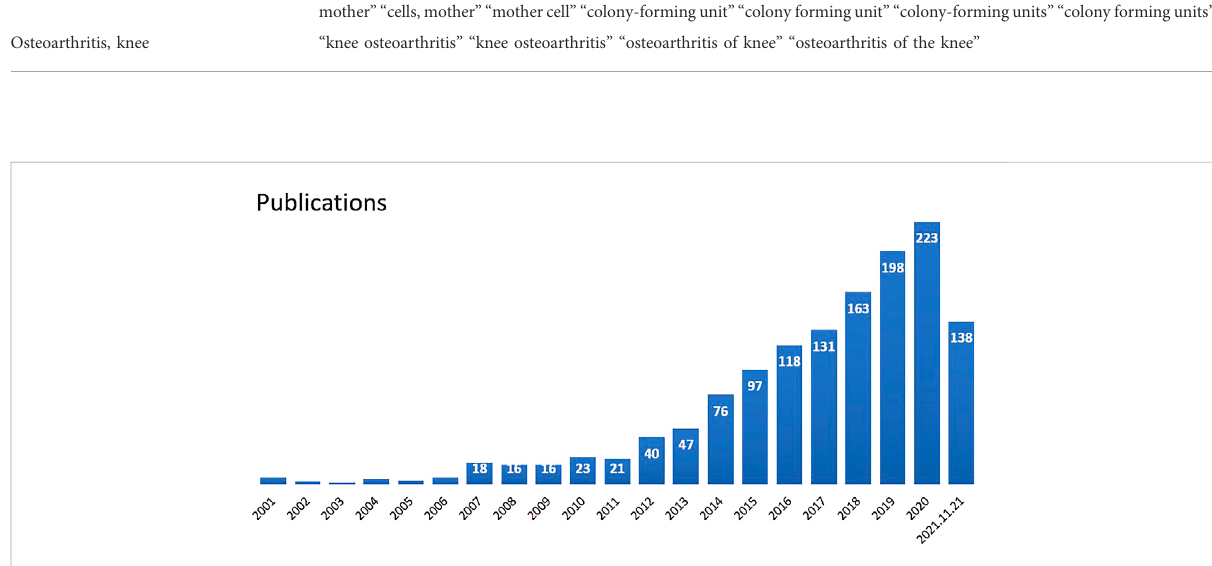
FIGURE 1 Annual outputs of publications regarding stem cell therapy for KOA and growth trends of